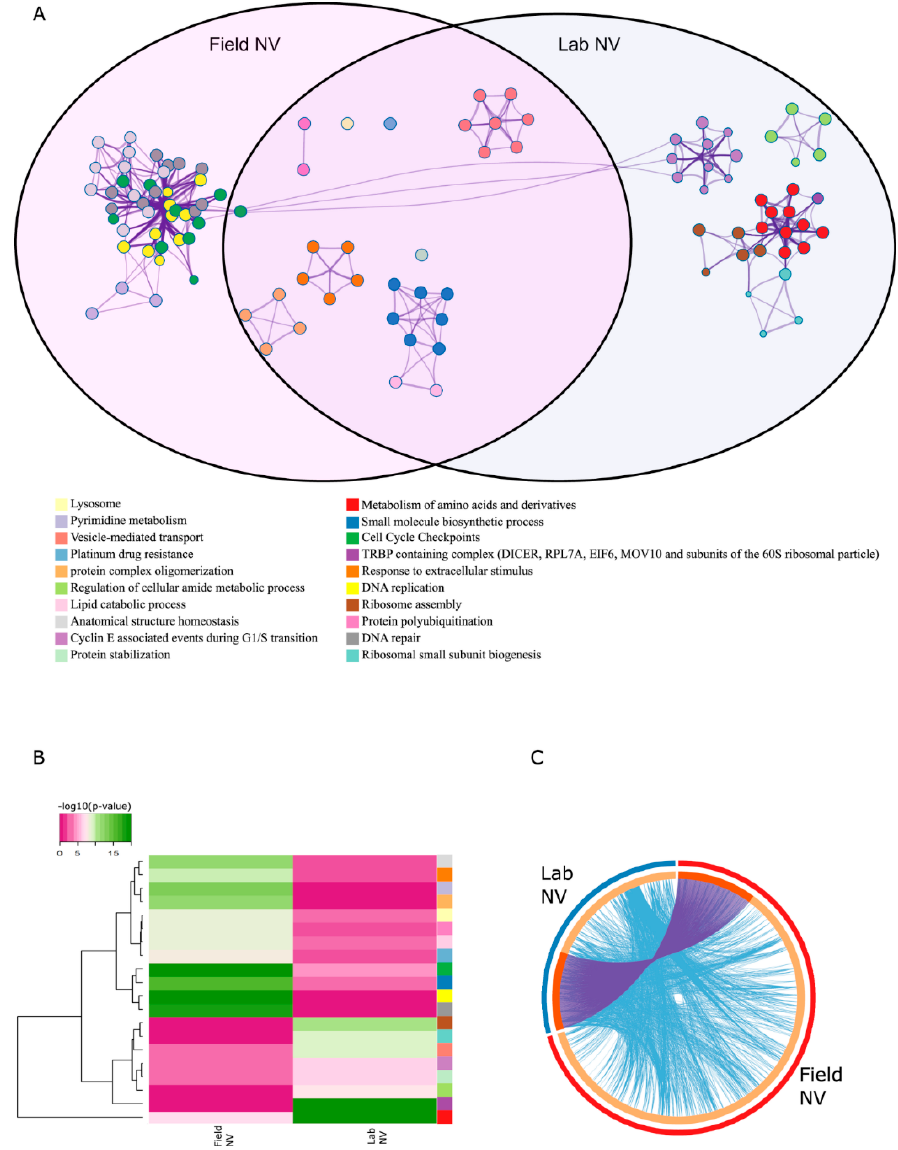
Figure 5. Enrichment analysis revealed different response pathways. ( A ) A subset of enriched KEGG pathways, gene ontology biological processes, gene ontology molecular functions, reactome gene sets, canonical pathways, and CORUM biological processes displayed in a network. Terms with a similarity score > 0.3 are linked by an edge (the thickness of the edge represents the similarity score). Each term is represented by a circular node, where the size is proportional to the number of input genes included in that term, and the color represents the cluster’s identity. Term labels are only shown for one representative term per cluster. Purple shading contains terms overrepresented in DE genes in the stress vs. pre-stress comparison of field-conditioned N. vectensis . Blue shading con- tains terms overrepresented in DE genes in the stress vs. pre-stress comparison of lab-cultured N. vectensis . ( B ) Heatmap representing enriched KEGG pathways, gene ontology biological processes, gene ontology molecular function, reactome gene sets, canonical pathways, and CORUM biological processes of the N. vectensis heat exposure response. The colors in the heat map represent statistical significance (–log10(P) value). The colors along the sides correspond to the legend above. ( C ) Circos plot describing overlaps in the heat exposure response (stress vs. pre-stress) between the two N. vectensis groups. The outermost circles are proportional to the number of enriched measured tran- scripts within each N. vectensis group. Inner circles indicate the proportion of measured transcripts